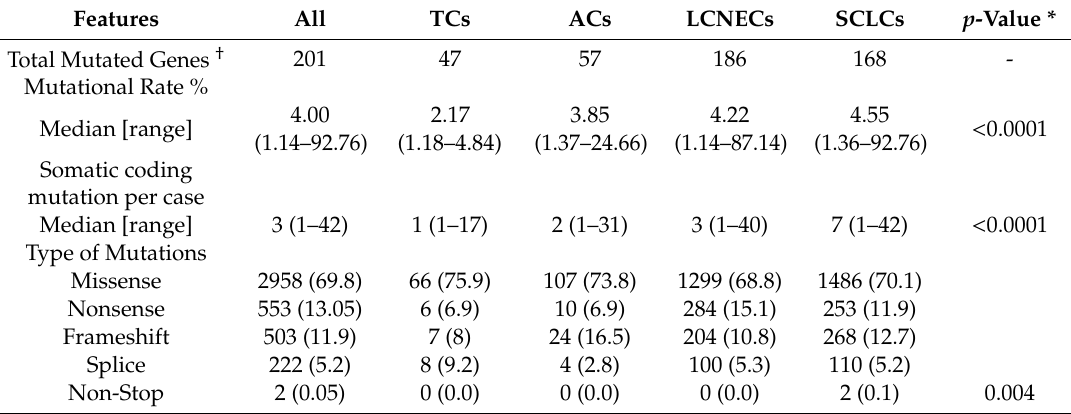
Figure 1. Selection of samples and genes for in Silico molecular analysis. Abbreviations: LNENs, lung neuroendocrine neoplasms; NGS, Next-generation sequencing. Table 2. Characteristics of mutated genes among WHO histological variants.